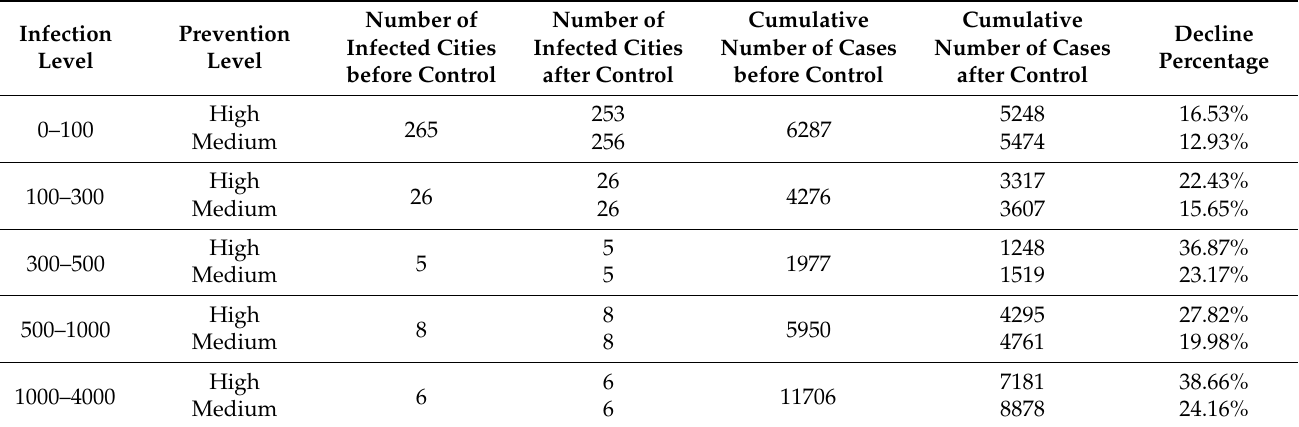
Table 9. Control effects of Strategy